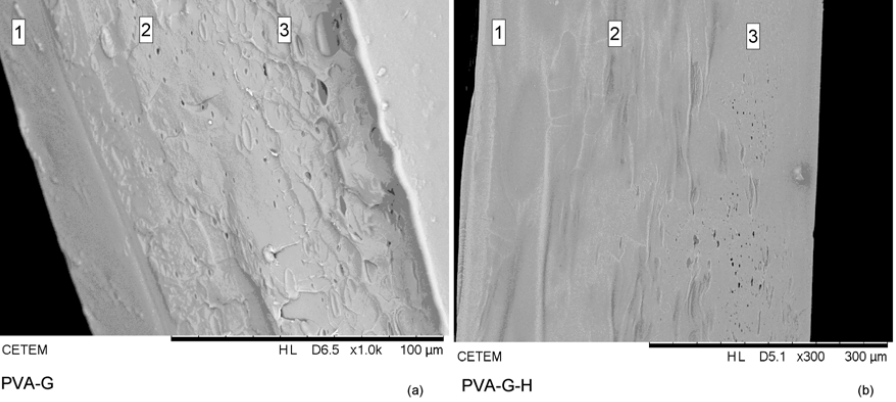
Figure 5. SEM of ( a ) PVA-G and ( b ) PVA-G-H samples.